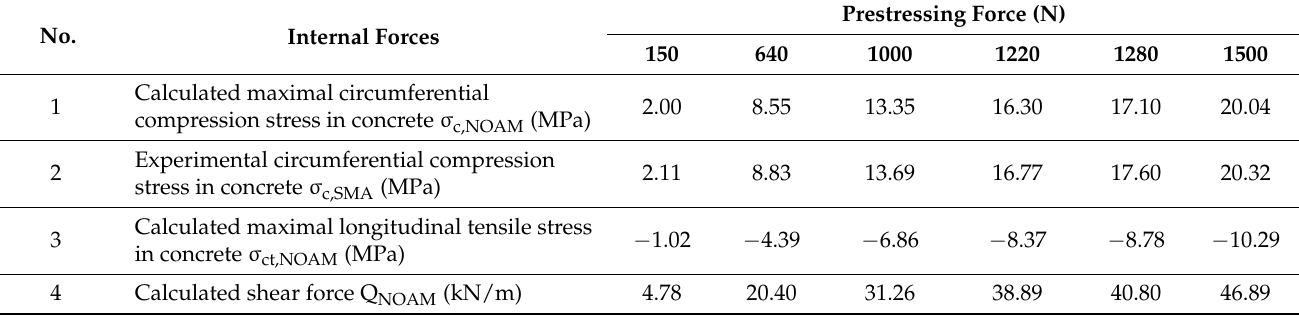
Table 1. Calculated and measured circumferential and longitudinal maximum concrete stress values and maximum cross-section force values in hollow cylinders with external diameter of 200 mm prestressed with Ni-Ti